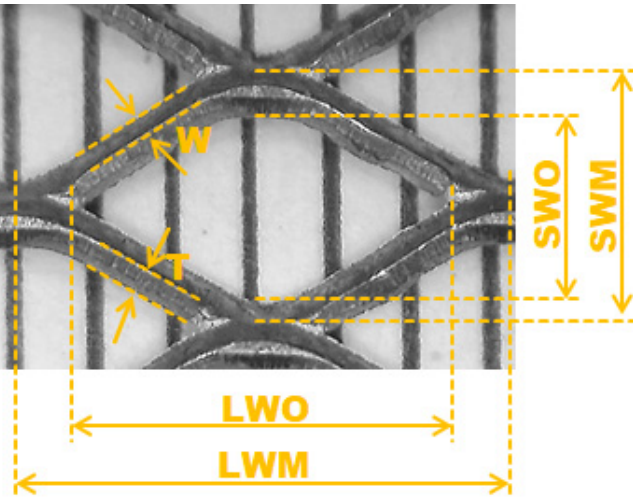
Figure 1. Photos of single expanded meshes ( A – C ).